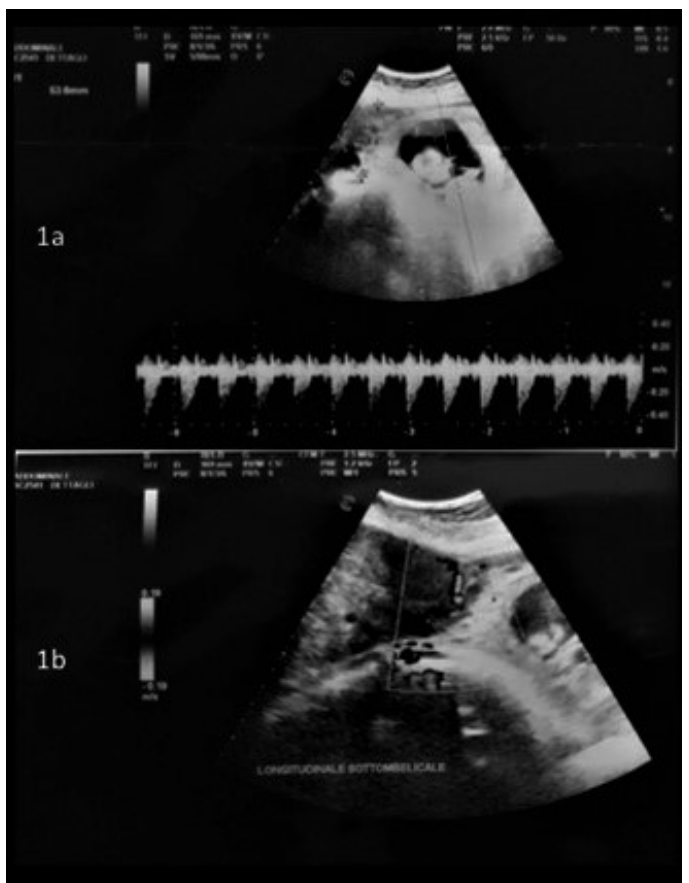
Figure 1. ( a ) Doppler ultrasound to check fetal heartbeat; ( b ) Assessment of the position of larger myoma and its pedicle.